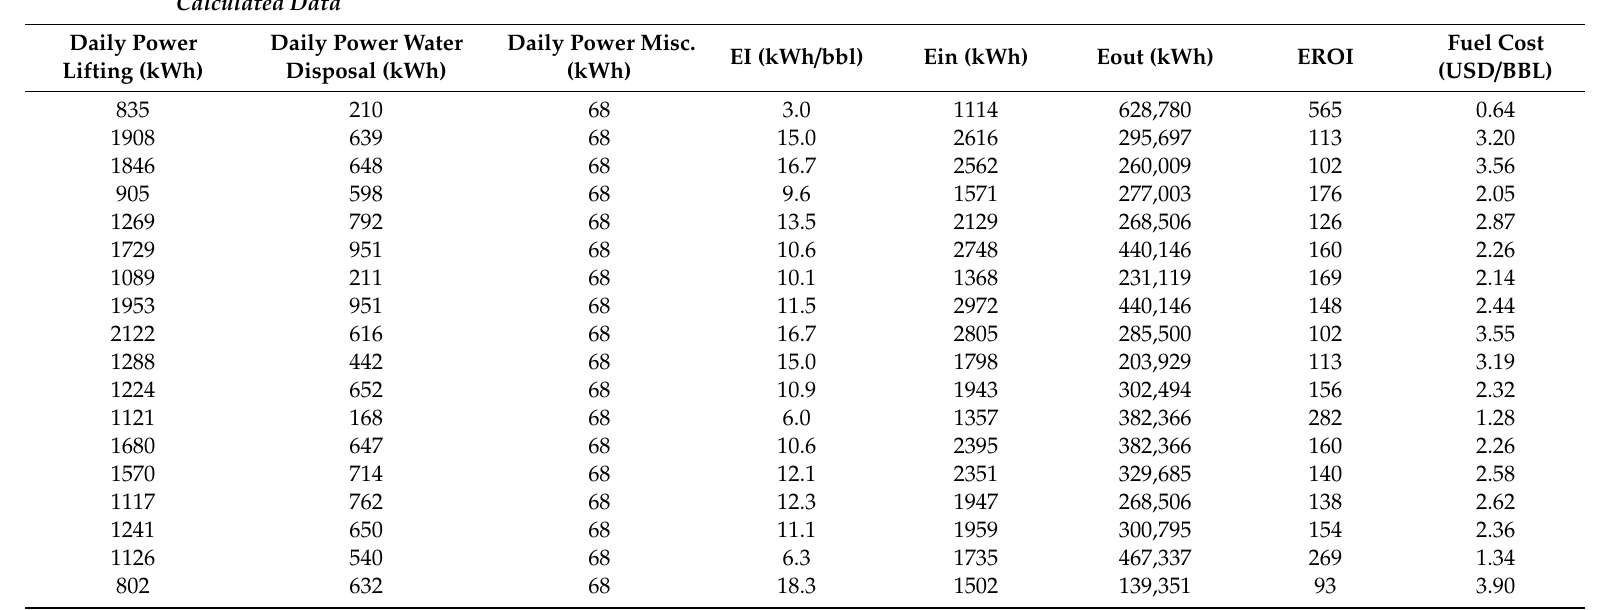
Table A2. Calculated data for well level EROI, EI, and fuel